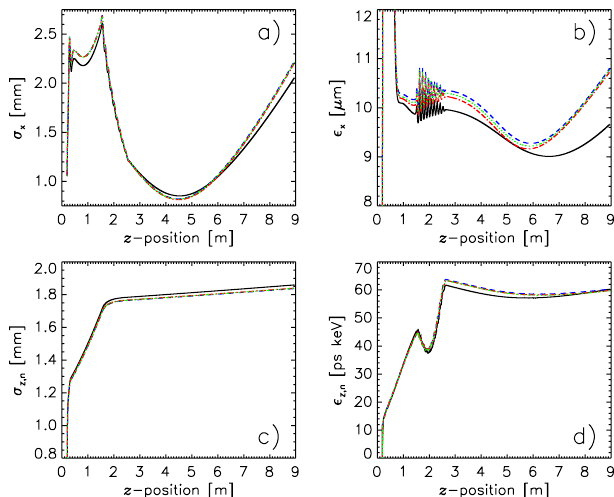
FIG. 12. (Color) Distribution 1 : Simulation results for the Fermilab/NICADD photoinjector performed with N 200 000 , and the standard version of IMPACT-T (black), IMPACT-T with PCG without denoising (green), IMPACT-T with PCG with thresholding and Anscombe transformation (blue), and IMPACT-T with PCG with thresholding and without Anscombe transforma- tion (red): rms beam radius [top left, panel (a)], rms normalized transverse emittance [top right, panel (b); note that the ordinate is magnified], rms bunch length [bottom left, panel (c); note that the ordinate is magnified], rms normalized longitudinal emit- tance [bottom right, panel (d)]. For IMPACT-T with PCG, we use Daubechies wavelets of order 2 ( M (cid:4) 4 ).